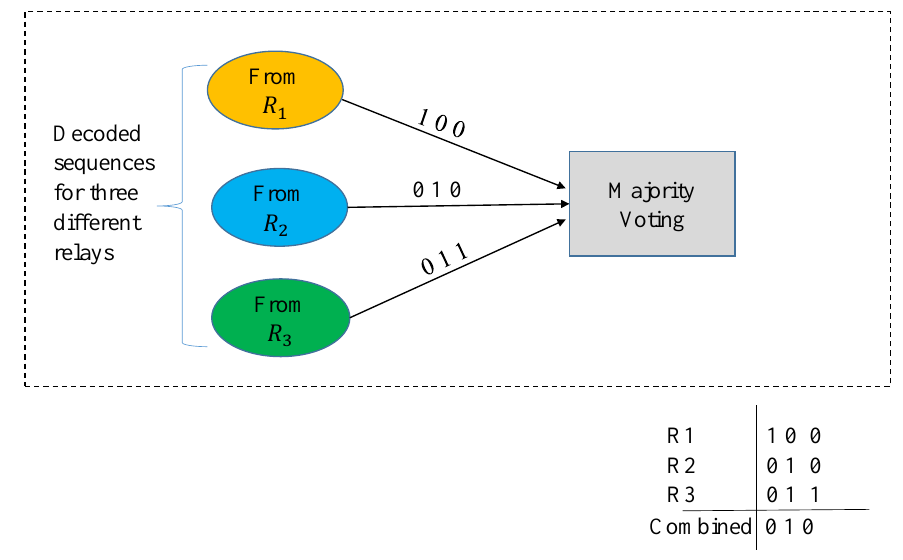
Figure 2. Post-detection combining with majority